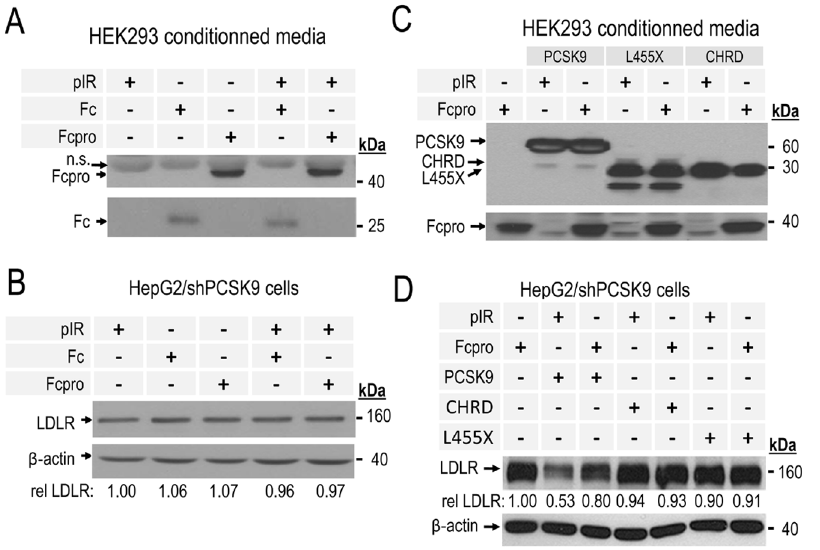
Figure 4. Extracellular trans -acting inhibitory effect of Fcpro co-incubated with PCSK9 on LDLR degradation. A ) and C ) Secreted Fc (human IgG1 fragment crystallizable region), Fcpro (Fc fused to PCSK9 prosegment), human wild type PCSK9 or its deletants forms L455X or CHRD proteins contained in conditioned media from transiently transfected HEK293 cells were analyzed following 10% SDS-PAGE by Western blot. Fc and Fcpro proteins were detected using a polyclonal anti-Fc antibody. n.s. indicate a non-specific band. PCSK9, L455X and CHRD proteins were detected using a mAb anti-V5. B ) and D ) HepG2/shPCSK9 cells were incubated with 1:3 (weight:weight) ratio of PCSK9 or L455X or CHRD to Fc or Fcpro amounts of proteins (quantified by ELISA assays) for 4 h at 37 u C. Cells were then lysed, and LDLR levels were analyzed by Western blot analysis and normalized relative to b -actin cellular loading controls. Total LDLR was detected using a polyclonal antibody anti-human LDLR and its levels were normalized relative to b -actin cellular loading controls. These data are representative of at least three independent experiments. A – D ) pIR: control empty pIRES vector.